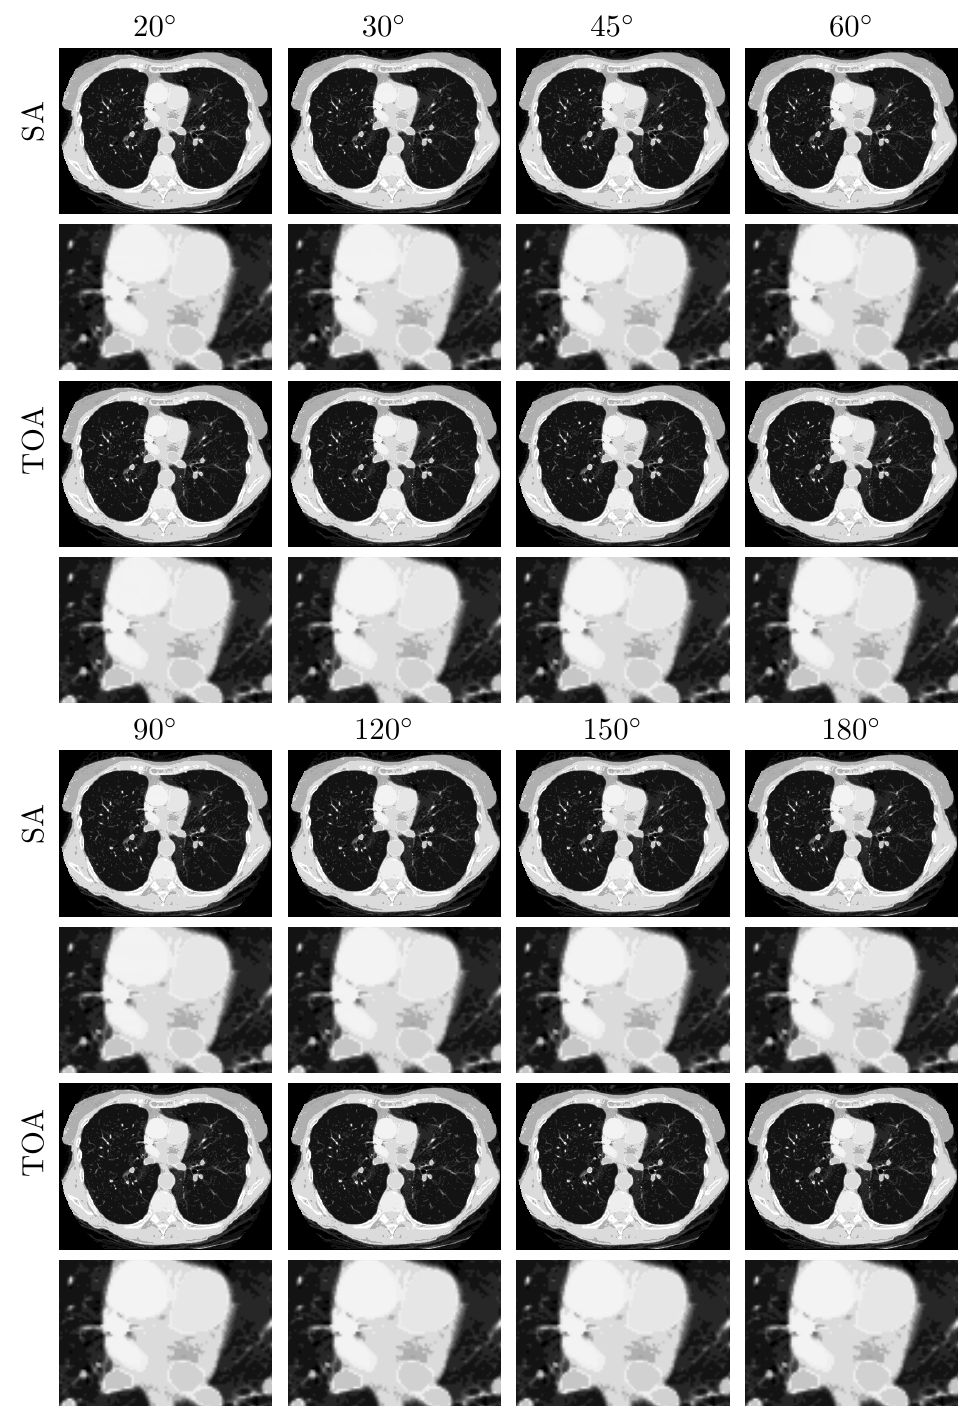
Figure 4. VMIs (rows 1, 3, 5, and 7), along with their respective zoomed-in views (rows 2, 4, 6, and 8), of the chest phantom at 100 keV obtained from noiseless data over SAs (rows 1&2 and 5&6) and TOAs (rows 3&4 and 7&8) of LAR 20 ◦ , 30 ◦ , 45 ◦ , 60 ◦ , 90 ◦ , 120 ◦ , 150 ◦ , and 180 ◦ , respectively, by use of the two-step method. Display window: [0, 0.22] cm − 1